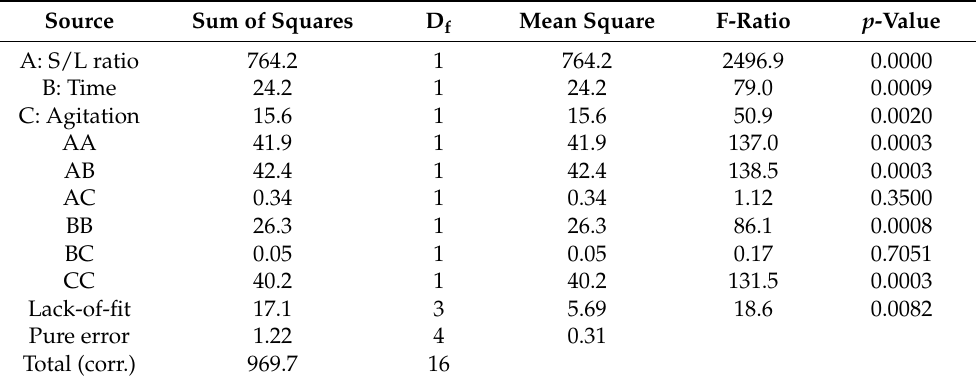
Table 3. Analysis of variance of the experimental results of the Box-Behnken design